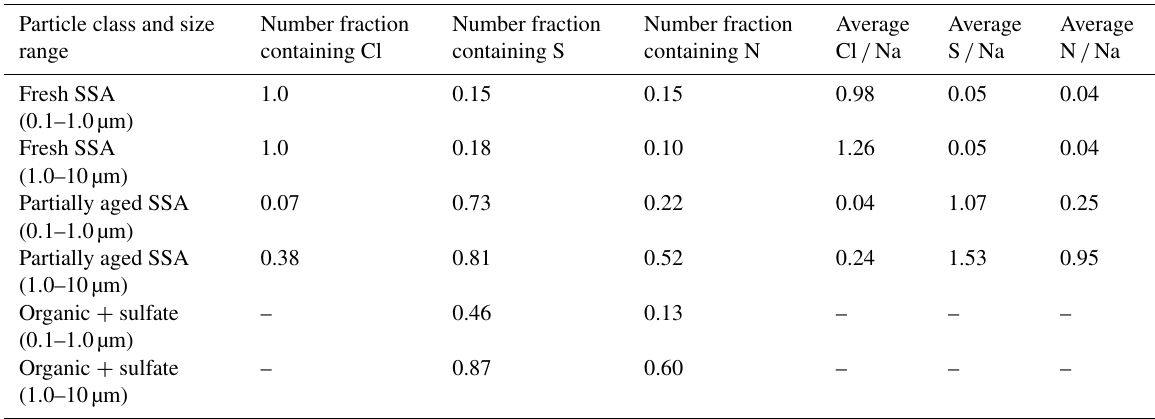
Table 1. Size-resolved number fractions of individual fresh SSA, partially aged SSA, and organic + sulfate particles containing Cl, S, and N, in addition to average atomic (mole) ratios of Cl / Na, S / Na, and N / Na for individual fresh and partially aged SSA. Particle class and size Number fraction Number range containing Cl